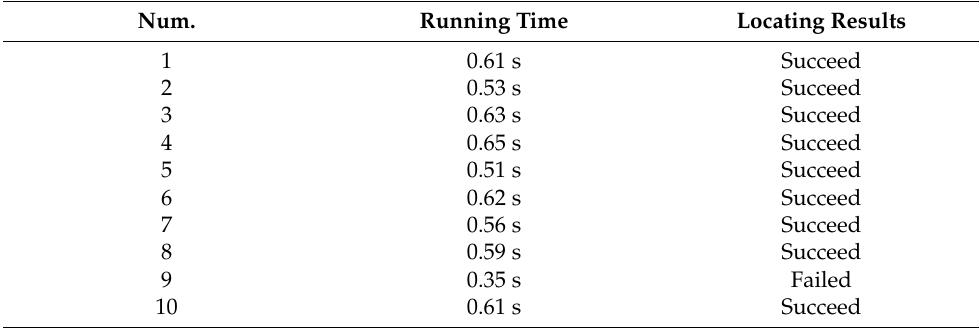
Table 3. Partial test